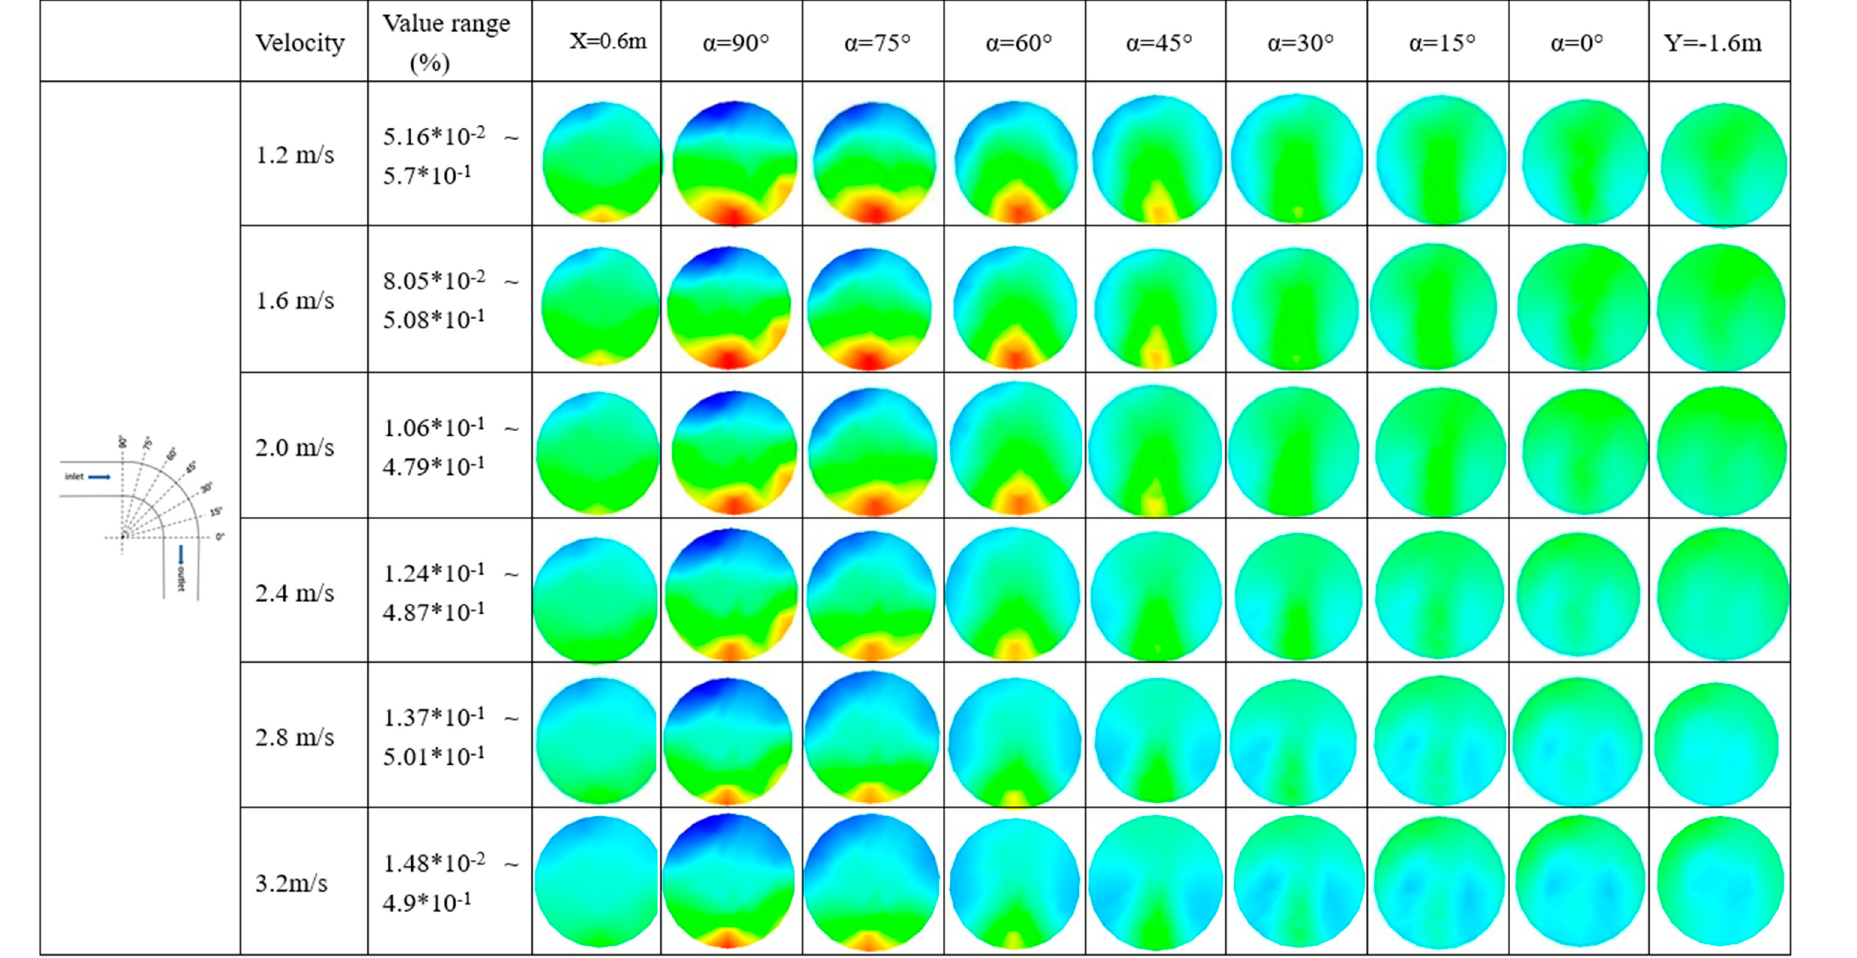
Figure 4. Cross-sectional contours of volume fraction distribution of CP at horizontal–vertical bend pipe.